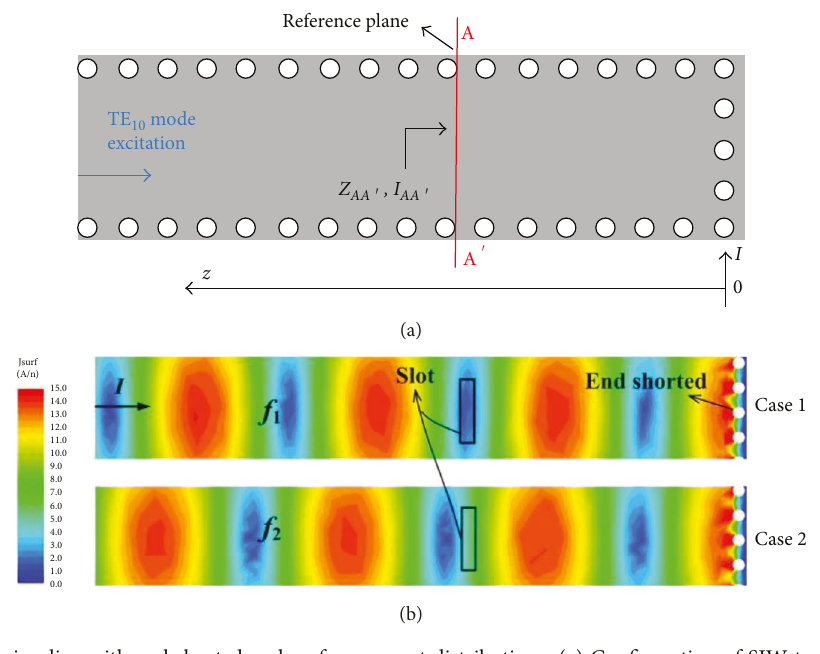
Figure 4: SIW transmission line with end shorted and surface current distributions. (a) Con fi guration of SIW transmission line with end shorted. (b) Surface current distributions at di ff erent frequencies.